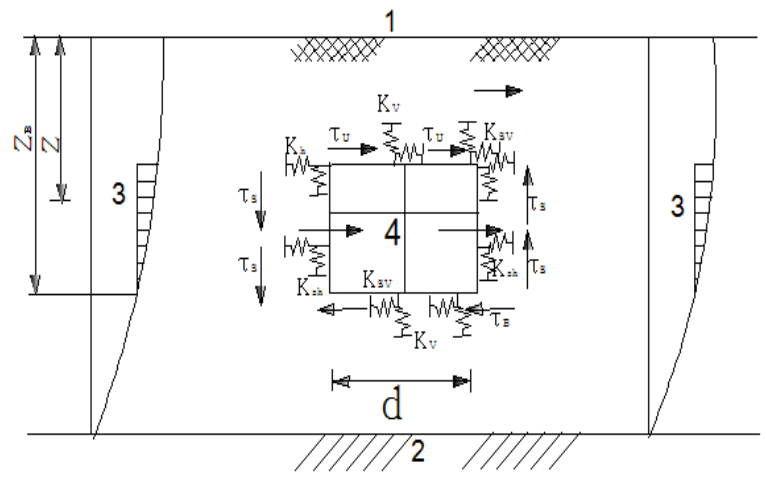
Figure 2. DBM calculation model.